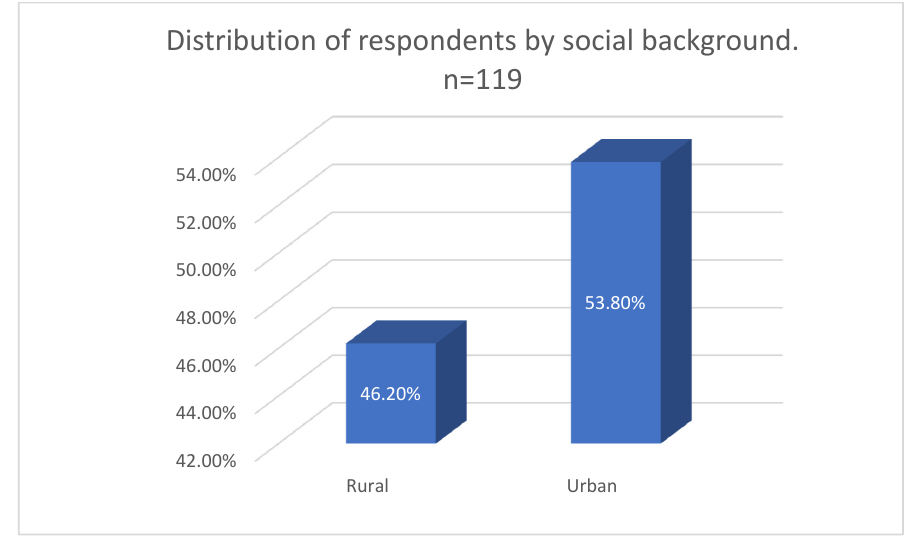
Figure 3. Distribution of respondents by social background.